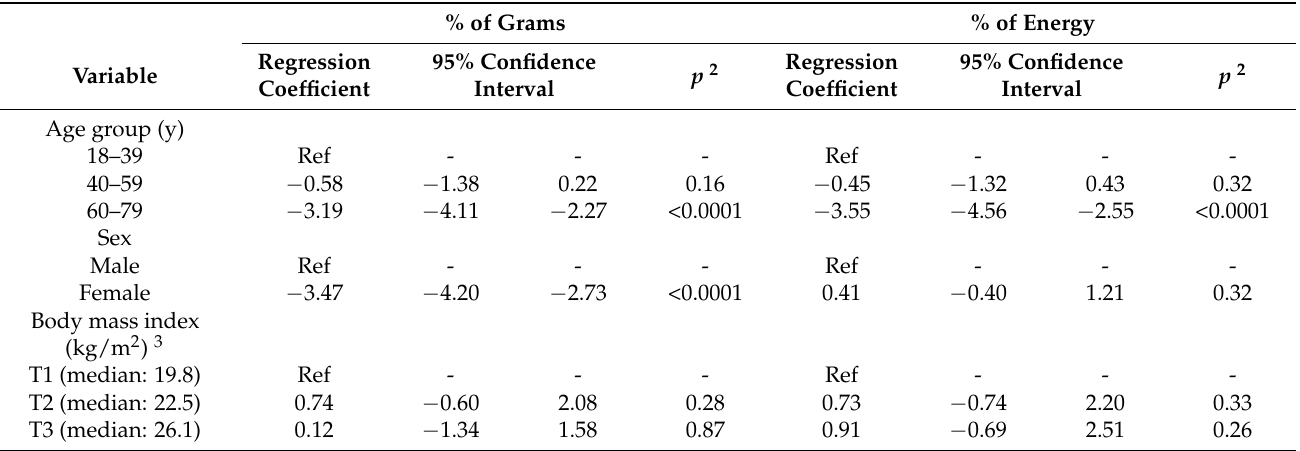
Table 5. Associations between basic characteristics and consumption of highly processed foods when foods classified using the low-estimate scenario 1 in the 8-day dietary record of 2742 Japanese